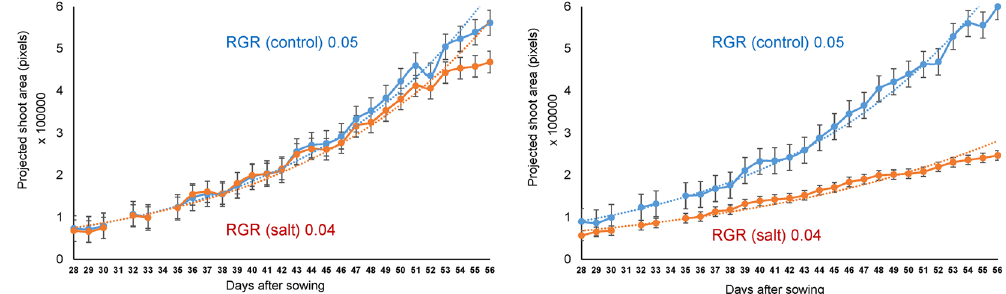
Figure 2. Non-destructive imaging of chickpea plants over time under 0 and 40 mM NaCl. Growth rates of ICC 95 (salt tolerant) and ICC 2720 (salt sensitive) under 0 mM NaCl (control) and 40 mM NaCl (salt). Plant growth is demonstrated by increments in projected shoot area (pixels) over time. Plants were imaged 3 days prior to salt application to establish a baseline for growth rate determination. Salt was applied in two equal increments, shown by orange vertical lines, at 31 DAS and 34 DAS and plants were imaged daily until 56 DAS to evaluate the effect of salt application on growth rate. Relative growth rate (RGR) is derived from the difference between the logarithms of the smoothed projected shoot area for 32 DAS and 56 DAS and then dividing by 24. Error bars are s.e.m.